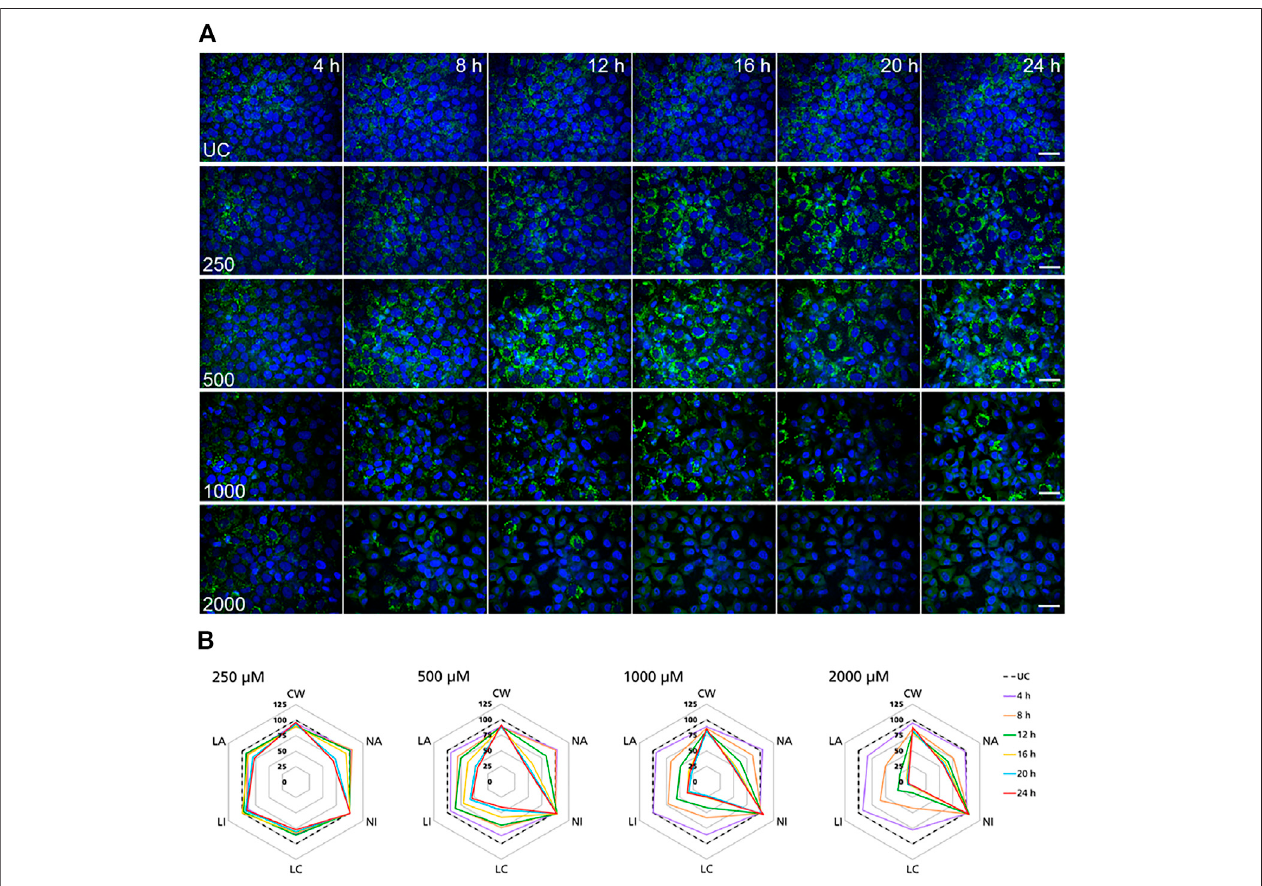
FIGURE4| Time-resolvedanalysisoftheeffectofpolymyxinBonNRK-52Ecells. (A) RepresentativeconfocalmicroscopyimagesofcellstreatedwithpolymyxinB (only selected concentrations are shown). Each row shows a different concentration (µM), each column represents a treatment time. Lysosomes stained with the fl uorescent dye LysoView ™ 633 are shown in green. Nuclei stained with the fl uorescent dye SYTO16 are shown in blue. Scale bar = 20 μ m. (B) Radar or spider-web diagrams based on relative values for selected image analysis parameters normalized against untreated control cells (UC) set to 100% (black dashed line). Each colouredlinerepresentatime pointbetween4and24 htreatment.Each diagramreferstoaselectedconcentration (onlyconcentrationsbetween250and 2000 µMare shown). UC = untreated control cells; CW = cells per well; NA = nuclei area; NI = nuclei intensity; LC = lysosomes per cell area; LI = lysosome integrated intensity; LA = total lysosome